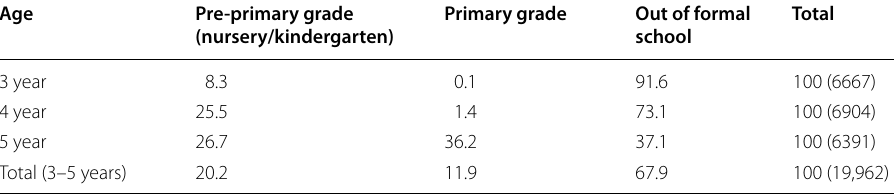
Figures in parentheses in the last column show the absolute number of